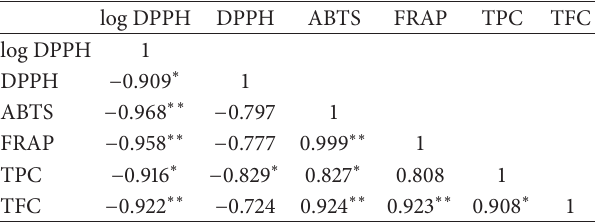
Table 4: Correlation matrix between the results of the total phenolic and flavonoid content and the FRAP, ABTS, and DPPH